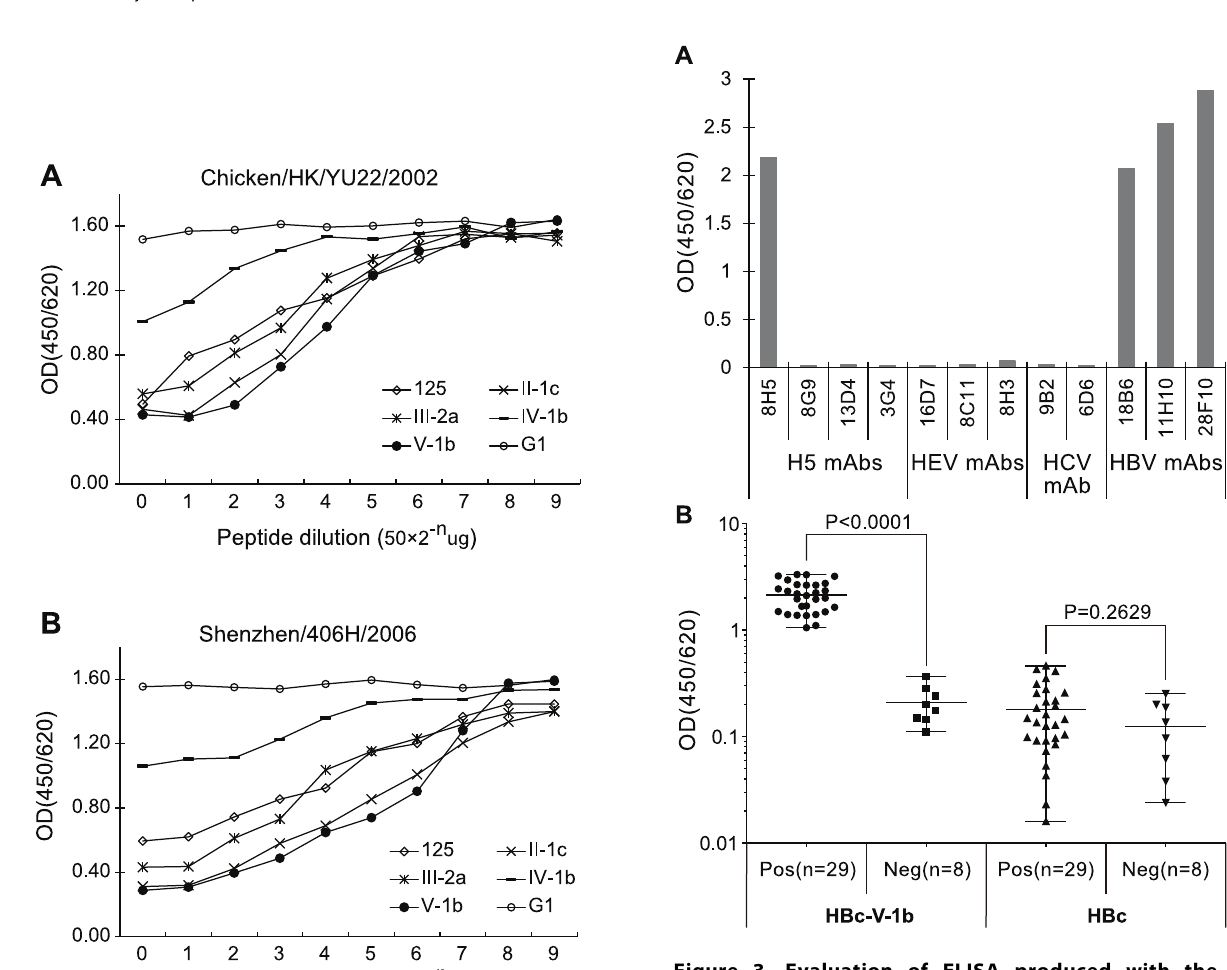
{ Residues which could be randomly substituted shown in parenthesis. { The 8H5 reactivity of phage bearing p125 and the related 12mer peptides was determined by titration as in Figure 1 and expressed in titer defined as the phage dilution yielding an OD value of 1.5 (T od1.5 ). * 8H5 reactivity of the respective peptides was determined as in Figure 2 and expressed in blocking dose, defined as amount of the peptide that block binding of 8H5 to the indicated strain of the H5N1 avian influenza virus by 50%. 1 Affinity of the peptides for 8H5 was determined by surface plasma resonance using BiaCore and expressed as dissociation constant (Kd).